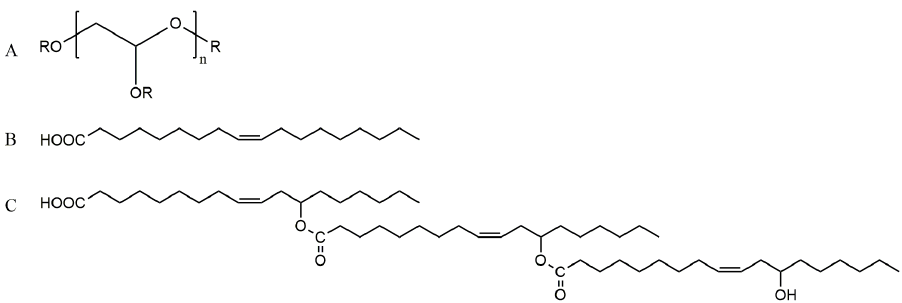
Figure 1. Chemical structure of polyglycerol ( A ); oleic acid ( B ) and polyricinoleate ( C ).